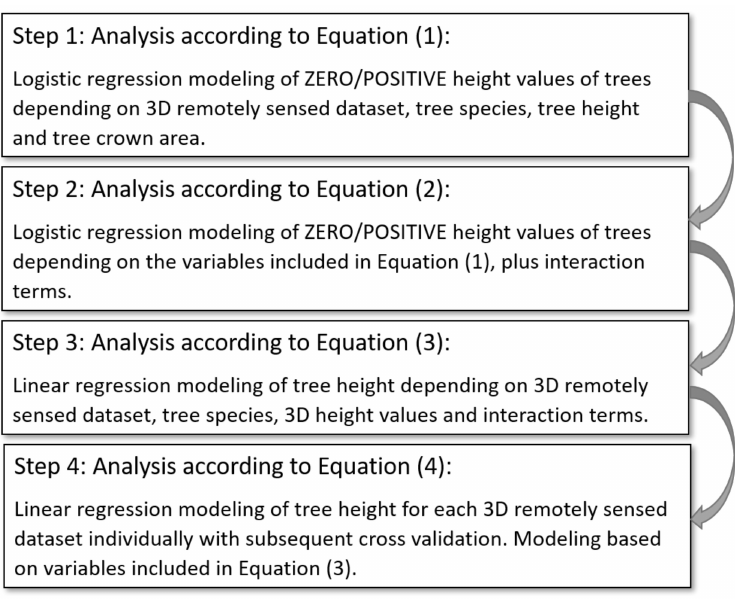
Figure 3. The sequence of analysis steps undertaken to address objective #1.